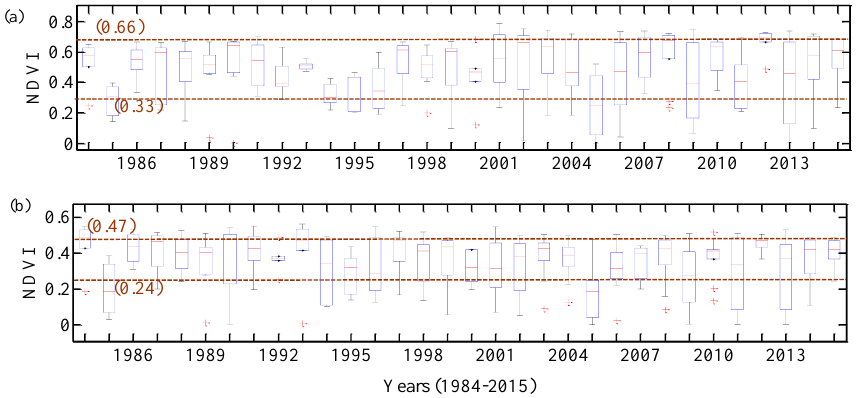
Figure 2. Boxplots of 30 Years of Vegetation Dynamics (Normalized Difference Vegetation Index, NDVI) at Apalachicola Bay for the ( a ) Freshwater Wetland (FW) and ( b ) Saltwater Wetland (SW). Horizontal line (red line) in ( a , b ), in each box indicates median demarcating 50% data either above or below the median whereas the dashed (brown) horizontal lines represent the average 25th and 75th percentiles for the two types of the wetlands studied here (corresponding percentile values are written inside parenthesis adjacent to the dashed brown lines).